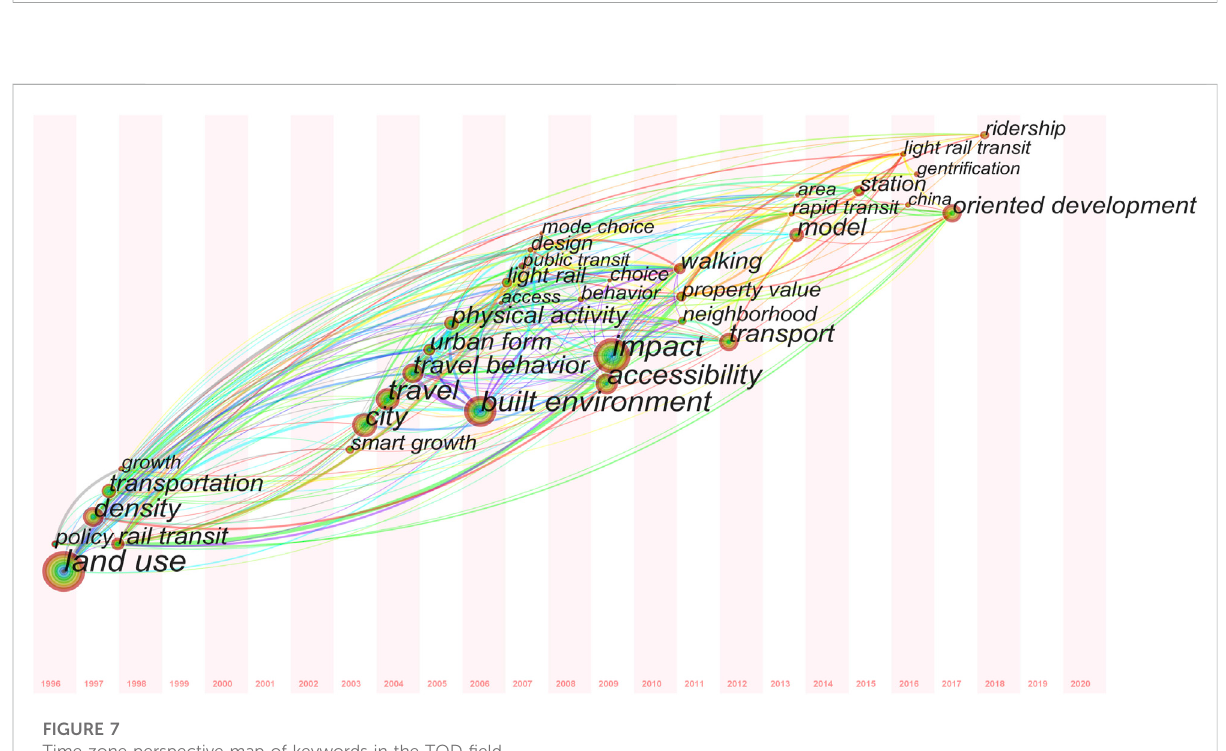
FIGURE 7 Time zone perspective map of keywords in the TOD fi